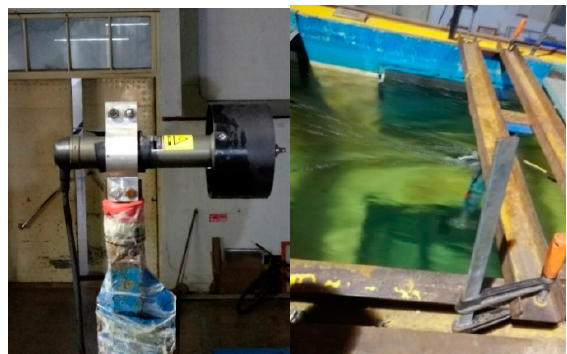
Figure 4. Testing of thrusters (left: fixing method; right: testing with current).